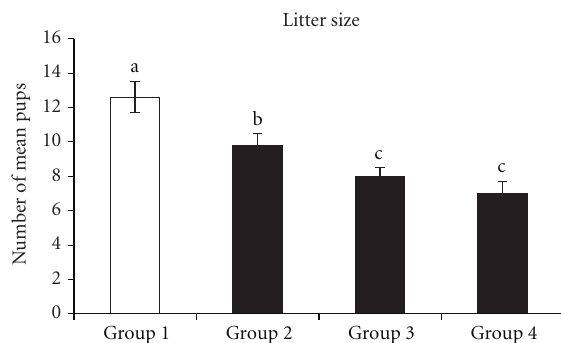
Figure 3: The litter sizes produced by the females of the control group (group 1) and groups exposed to elevated ambient tem- perature. The bars represent the mean ± SEM. Data labeled with di ff erent letters are significantly di ff erent at P < 0 . 05.